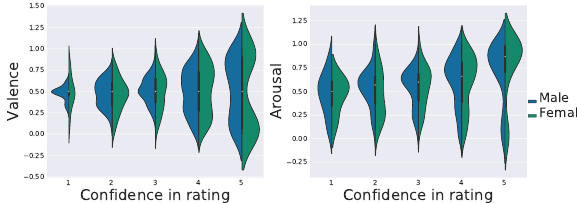
Figure 5: Kernel density estimates of the ratings with respect to the raters’ confidence level (0:"not confident at all" to 5:"very confi-